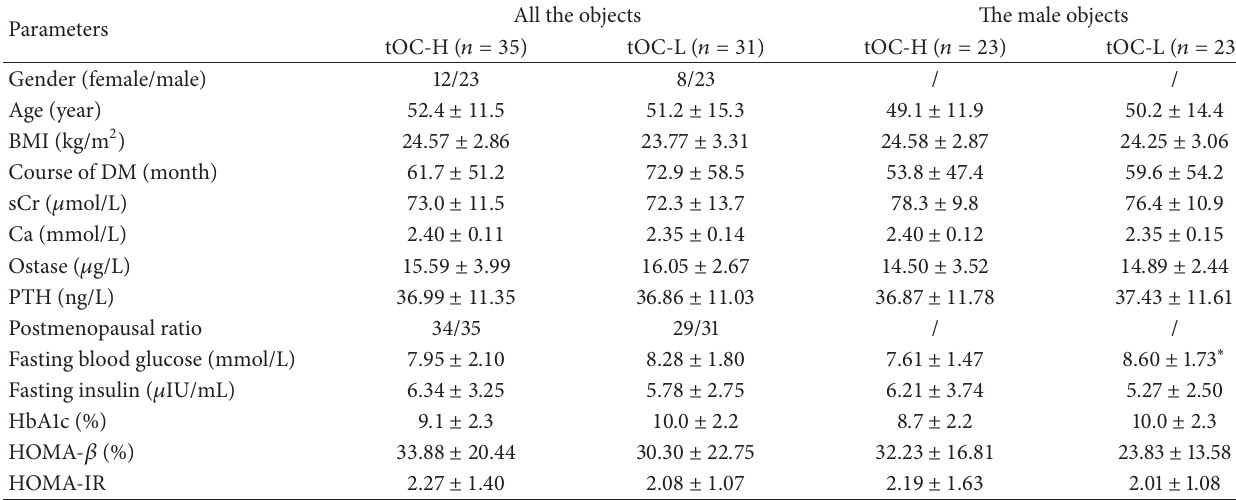
Table 3: Comparisons between Group tOC-H and Group tOC-L.